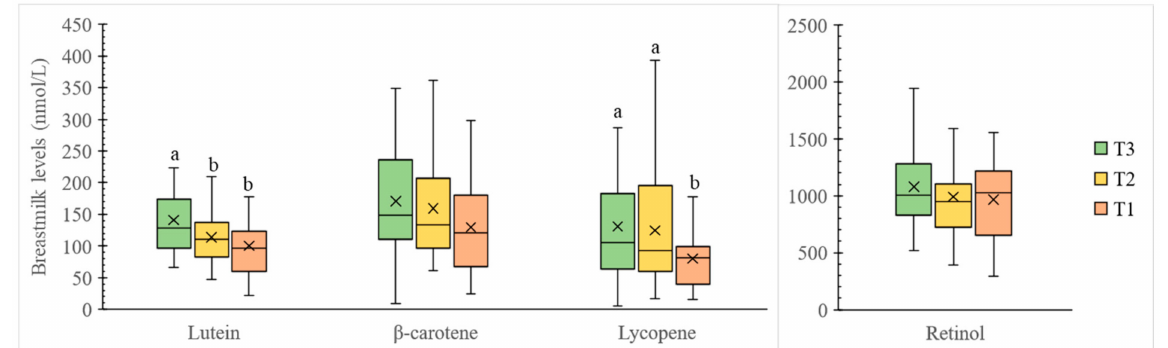
Figure 3. Box plots of major carotenoid and retinol contents (nmol/L) in breastmilk categorized by total carotenoid intake from food only. Boxes represent the 25th, 50th, and 75th percentiles. Crosses represent mean. Whiskers represent either minimum/maximum or 25th/75th minus/plus 1.5 × interquartile range, whichever is closer to the median. Different superscript letters indicate a significant difference in carotenoid or retinol content in human milk from different groups ( p < 0.05) based on one-way ANOVA test with post hoc Bonferroni test. Participants in T3 ( n = 29) had the highest carotenoid intake of 10.0–32.0 mg/day, T2 ( n = 29) had the median carotenoid intake